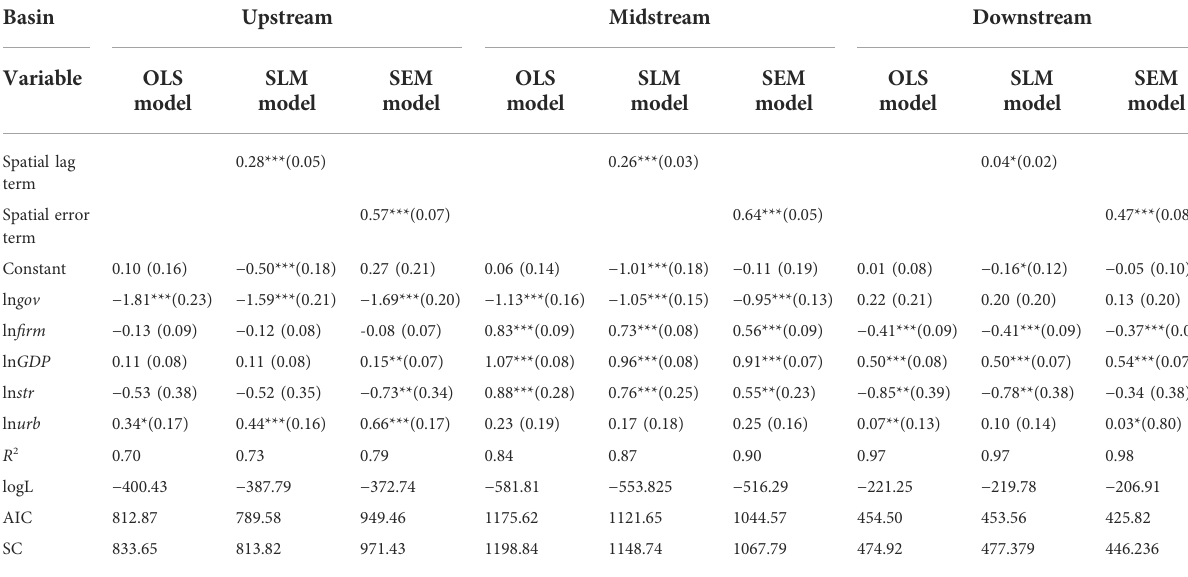
TABLE 4 Estimated results of OLS and spatial econometric models in the upstream, midstream, and downstream of the YRB. Basin Upstream